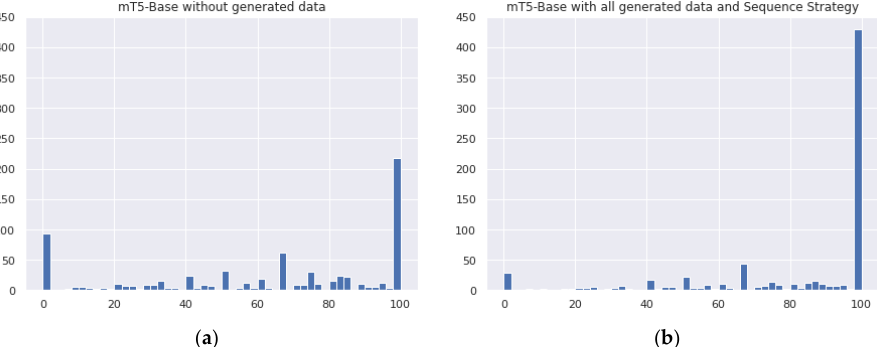
Figure 11. F1 distribution of the iApp Wiki QA dataset: ( a ) the result from the mT5-Base baseline model, and ( b ) the result from the combination mT5-SEQ-ALL of the iApp Wiki QA dataset.